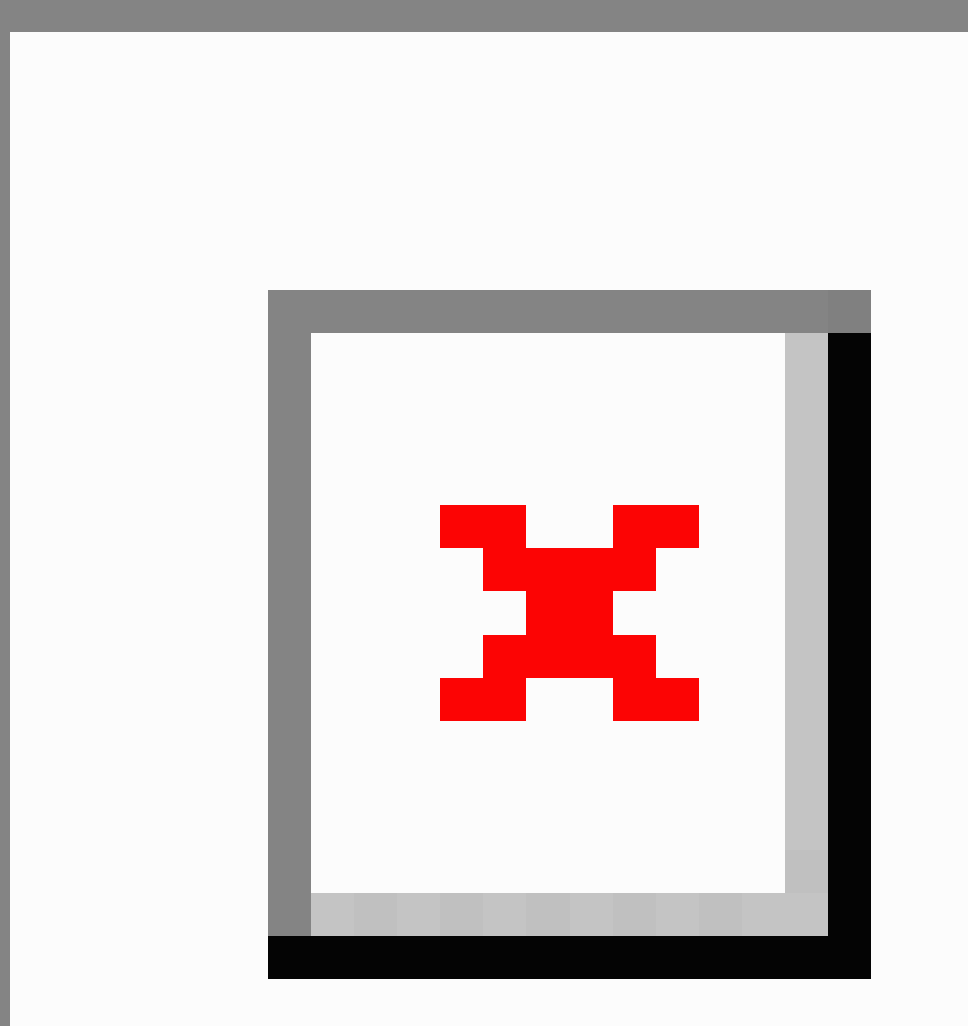
Figure 3. Percentage of MS patients (N=40) with high level of psychological or physical